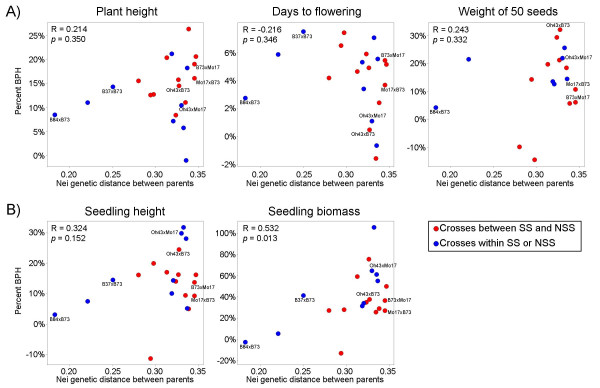
Relationship between parental genetic diversity and hybrid heterosis among traits and hybrids. The percentage better parent heterosis (BPH) for each hybrid is plotted against the genetic distance between parents. The 25 hybrids were scored based on percentage BPH for five traits (plant final height, days to flowering, weight of 50 seeds, 11-day height and 11-day biomass). Traits measured on field-grown plants are shown in (A) and traits measured on greenhouse-grown plants are shown in (B). Average percent BPH is shown based on two field replicates (A) and three greenhouse replicates (B). Spots representing crosses between stiff stalk (SS) and non-stiff stalk (NSS) groups are shown in red, and spots representing crosses within either group are shown in blue. The Pearson's R correlation value and p-value of the regression are shown for each trait. The six hybrids that were used for expression profiling are labelled in each of the five plots.